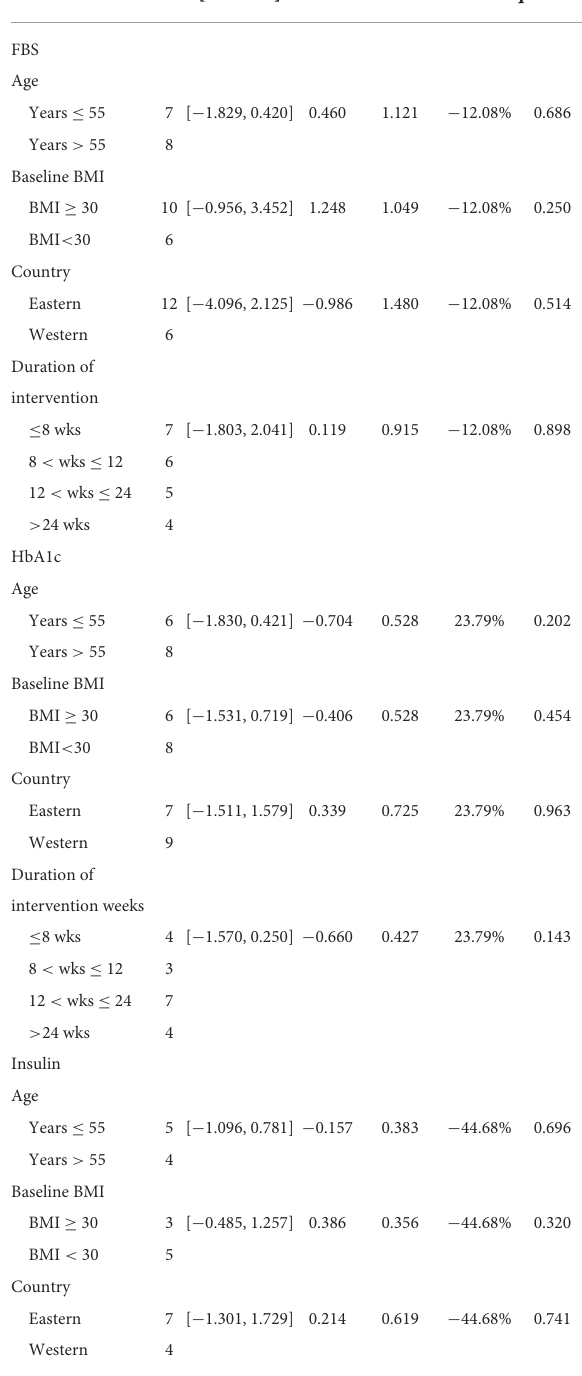
TABLE 3 Results of meta-regression analyses with age, BMI, country, and duration of intervention in all indexes (FBS, HbA1c, Insulin, HOMA-IR, TC, TG, HDL-C, LDL-C, SBP, and DBP) as independent variables. n [95% CI] Coef. Std.